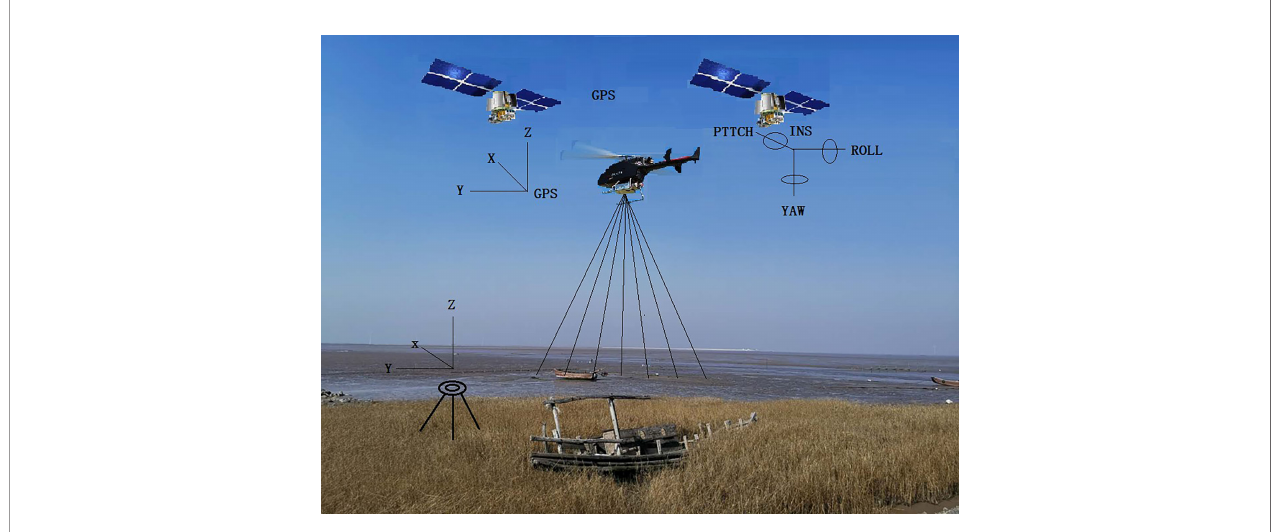
FIGURE 3 | Schematic diagram of airborne LiDAR